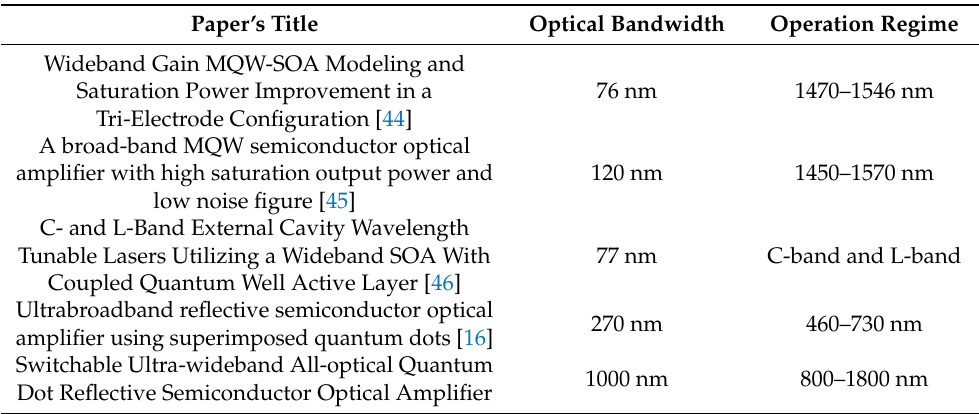
Table 2. Reported broadband optical amplifiers with their corresponding optical bandwidth and operation